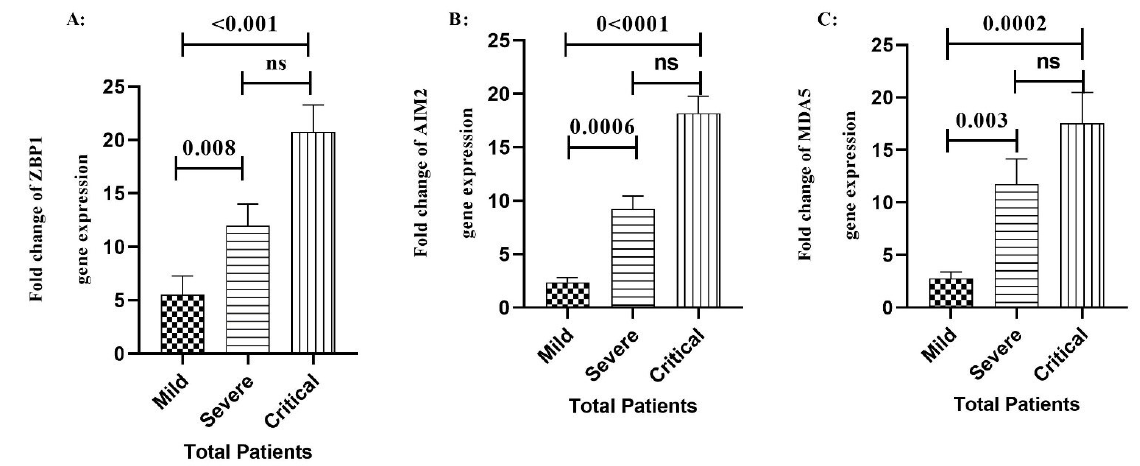
Figure 2: Comparison of the expression of ZBP1 A) , AIM2 B), and MDA5 C) genes in different stages of the COVID-19 patients. Data are presented as fold change. ns: not significant. There are difference between specified groups (p < 0.05).